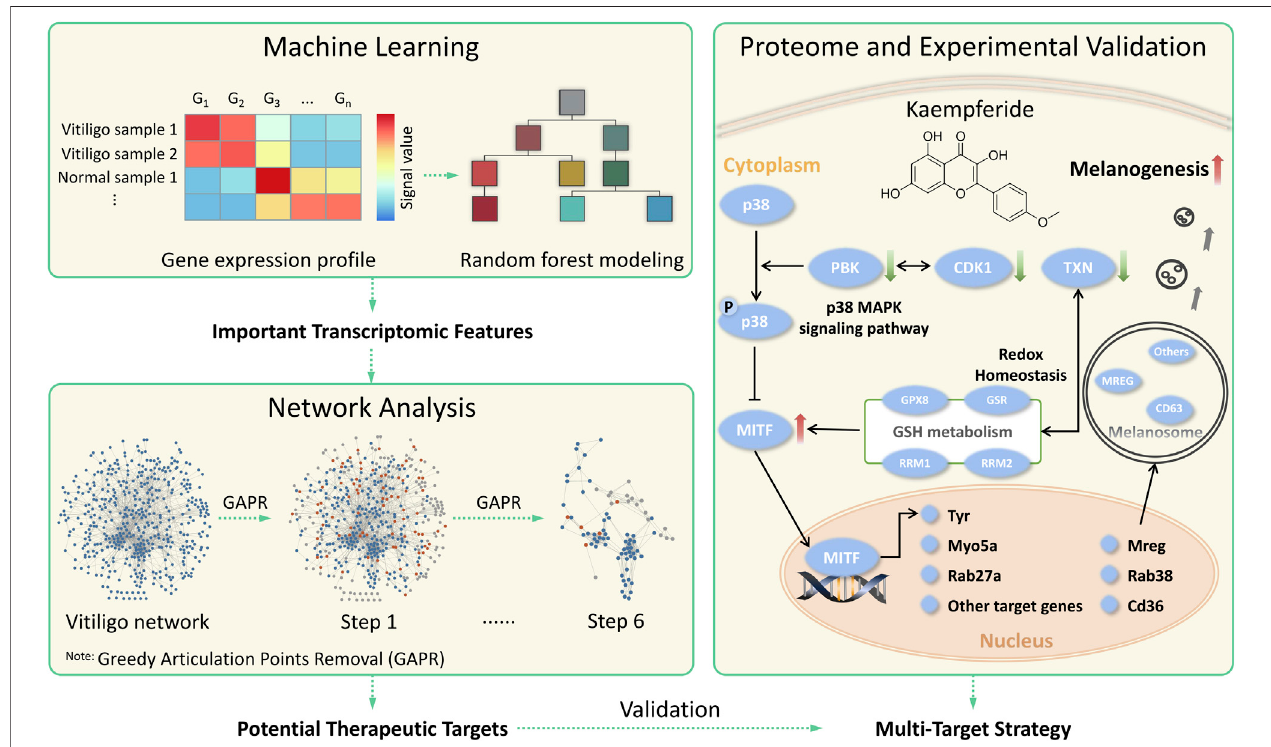
FIGURE 1 | The systematic framework to discover potential therapeutic strategies for vitiligo by combining machine learning and network analysis together.